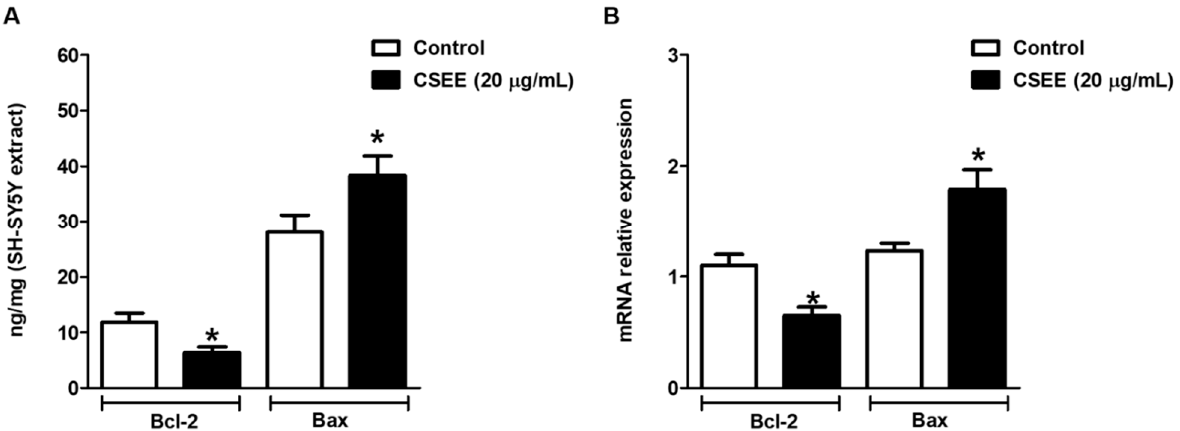
Figure 7. Effects of CSEE on Bax and Bcl2 expression. ( A ) CSEE reduces Bcl-2 protein level and increases the Bax protein level of SH-SY5Y cells (* p < 0.05). ( B ) CSSE reduces Bcl-2 mRNA levels and increases mRNA levels of SH-SY5Y cells (* p < 0.05). Values are expressed as mean ± SEM. SH-SY5Y cells were treated with 20 µg/mL of CSEE for 24 h. Data shown are representative of three independent experiments.